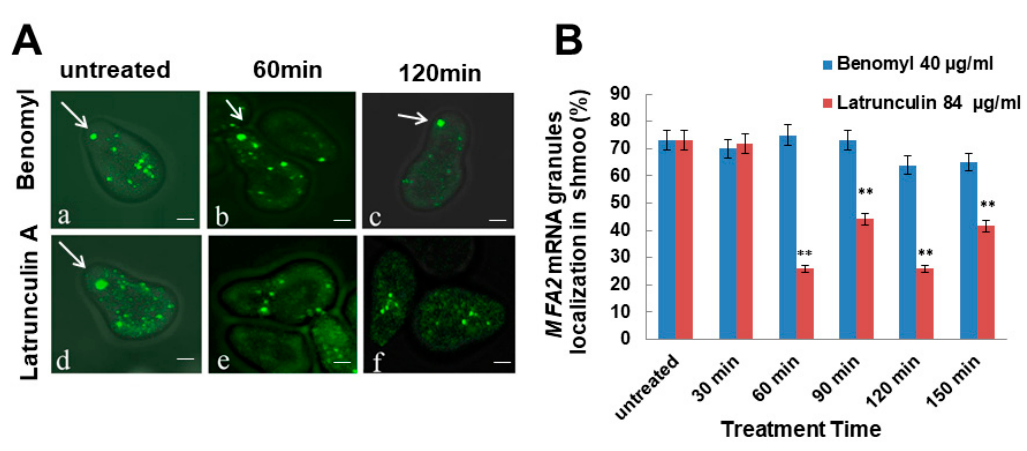
Figure 8. MFA2 mRNA containing granules dissociated in response to Latrunculin, but not Benomyl treatment. ( A ) Cells expressing MFA2 mRNA were treated with α F for 2 h. Benomyl (40 µg/mL) or lantunculin (84 µg/mL) was added to the cells which were then observed by fluorescence microscopy for 150 min. White arrows indicate MFA2 mRNA localization in the shmoo tip. ( B ) The percentages of high intensity granules in the shmoo were calculated before and up to 150 min after addition of the drug. Error bars represent the standard deviation from three independent experiments. The star signifies a significant difference ( p < 0.001) of MFA2 mRNA distribution compared to untreated controls. 200–250 cells were counted. Scale bar = 2 µm.